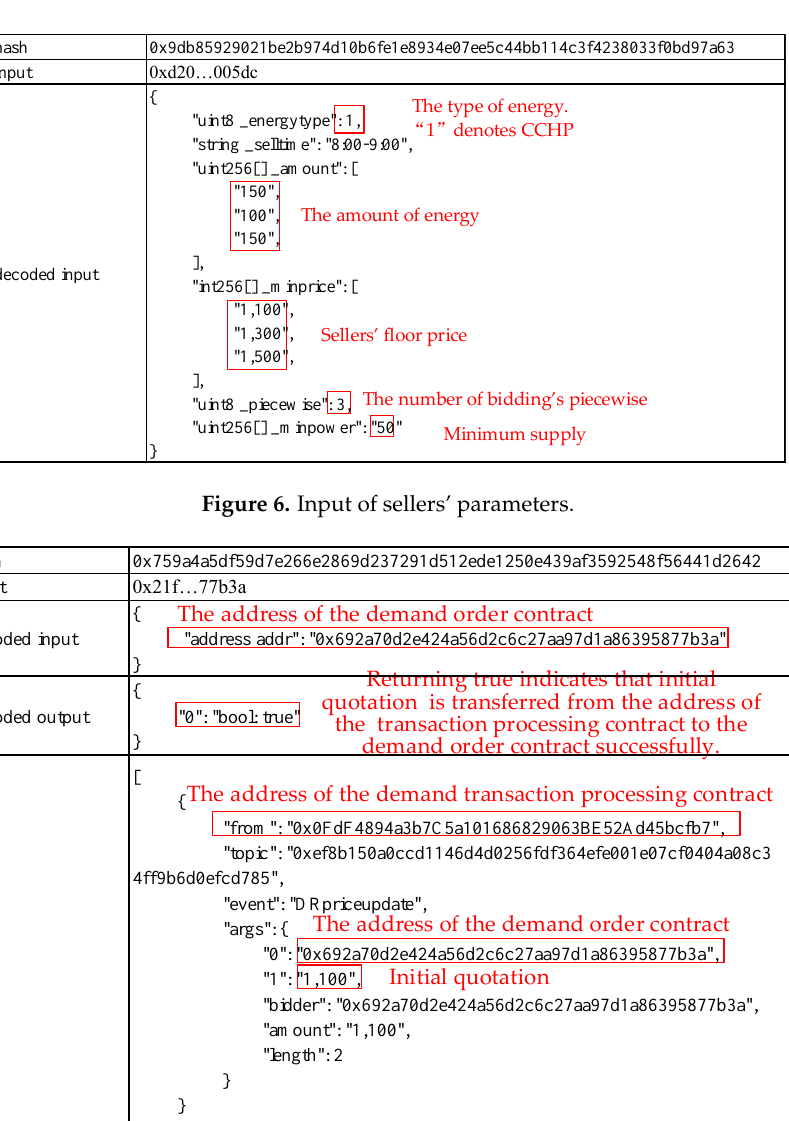
Table 7. Seller s’ parameters.